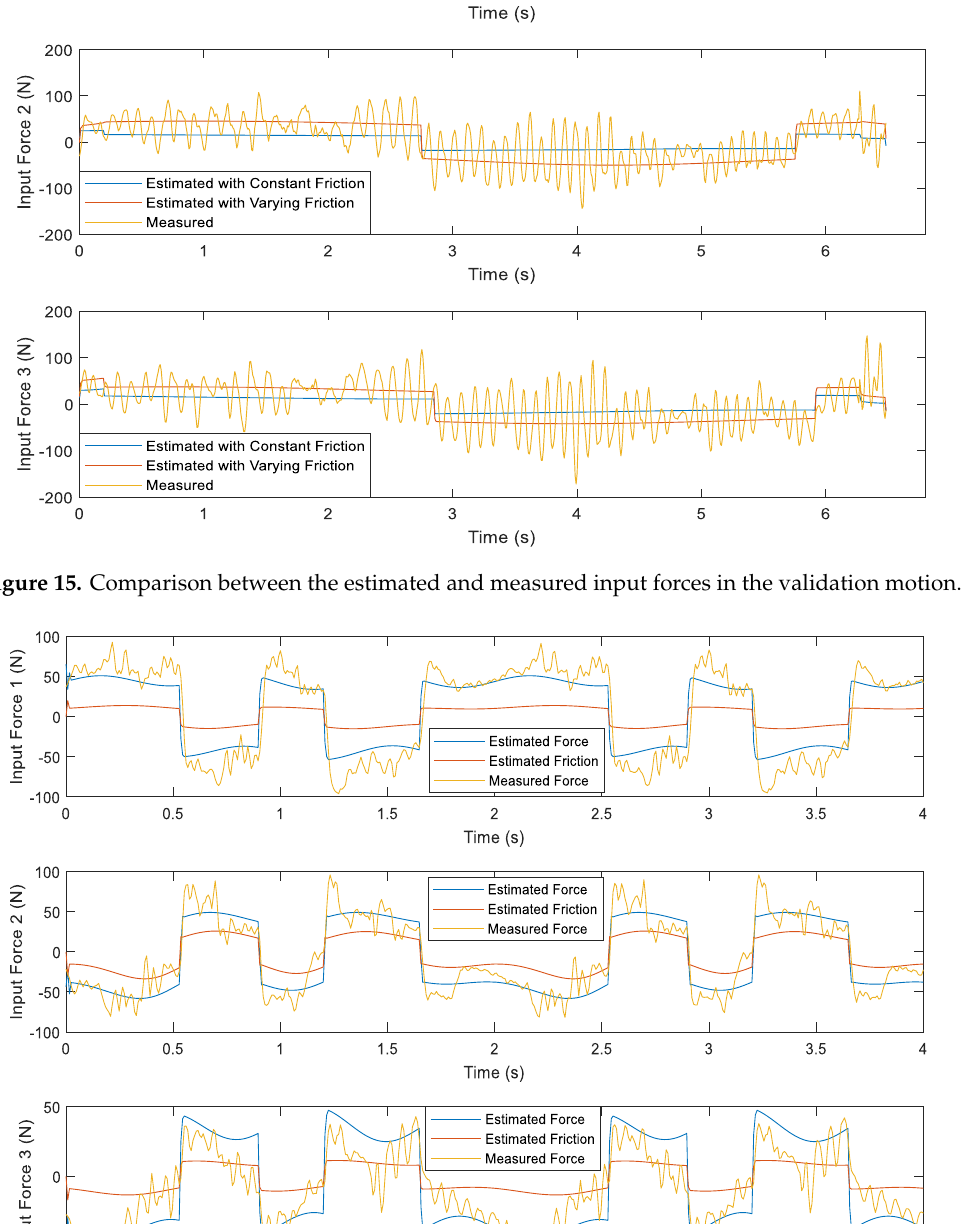
Figure 16. Comparison between the estimated friction forces and the estimated input forces.